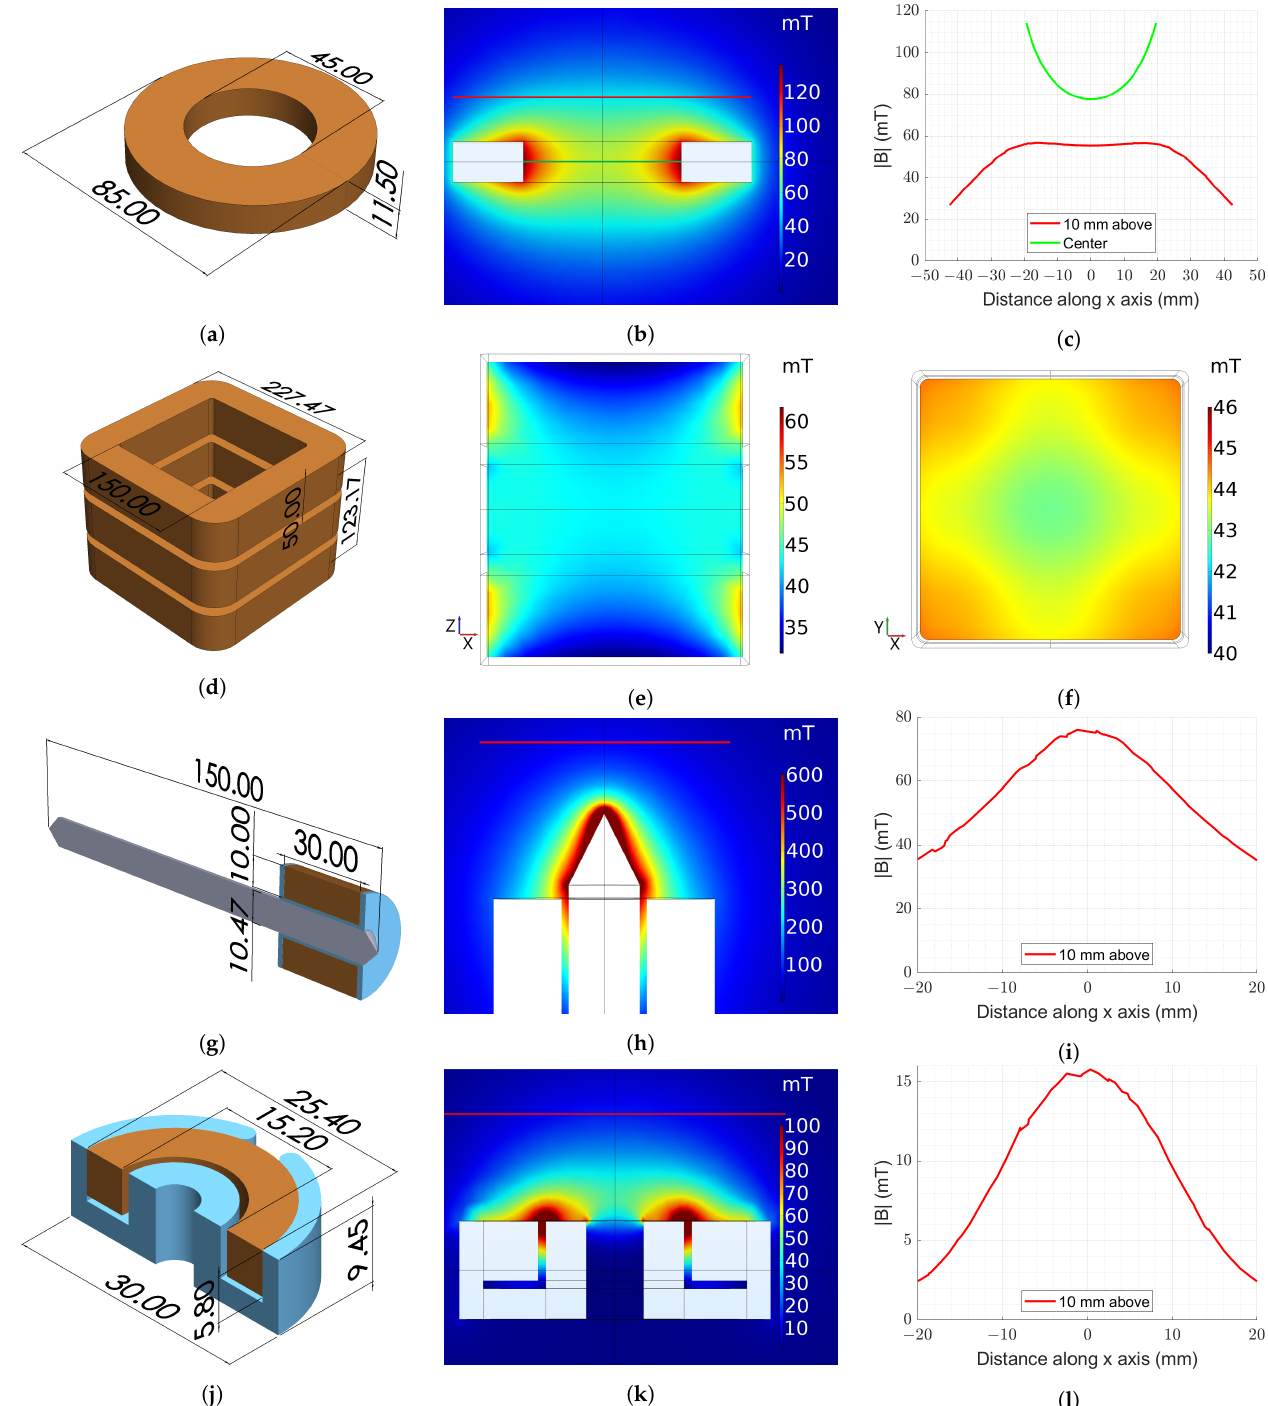
Figure 2. Electromagnet geometries and simulated | B | distributions. Dimensions for the ( a ) air core coil; ( d ) three-coil system; ( g ) ferromagnetic core coil; and ( j ) pot core coil. Simulated | B | distributions for the ( b ) air core coil; ( e ) three-coil system XZ plane; ( f ) three-coil system XY plane; ( h ) ferromagnetic core coil; and ( k ) pot core coil. The superimposed lines represent the location of the line scans ( c ) for the air core coil; ( i ) ferromagnetic core coil; and ( l ) pot core